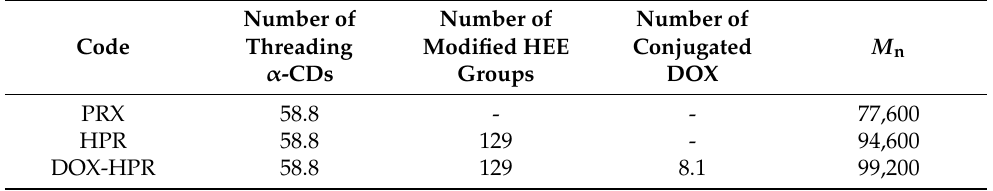
Table 1. Characterization of PRXs used in this study.